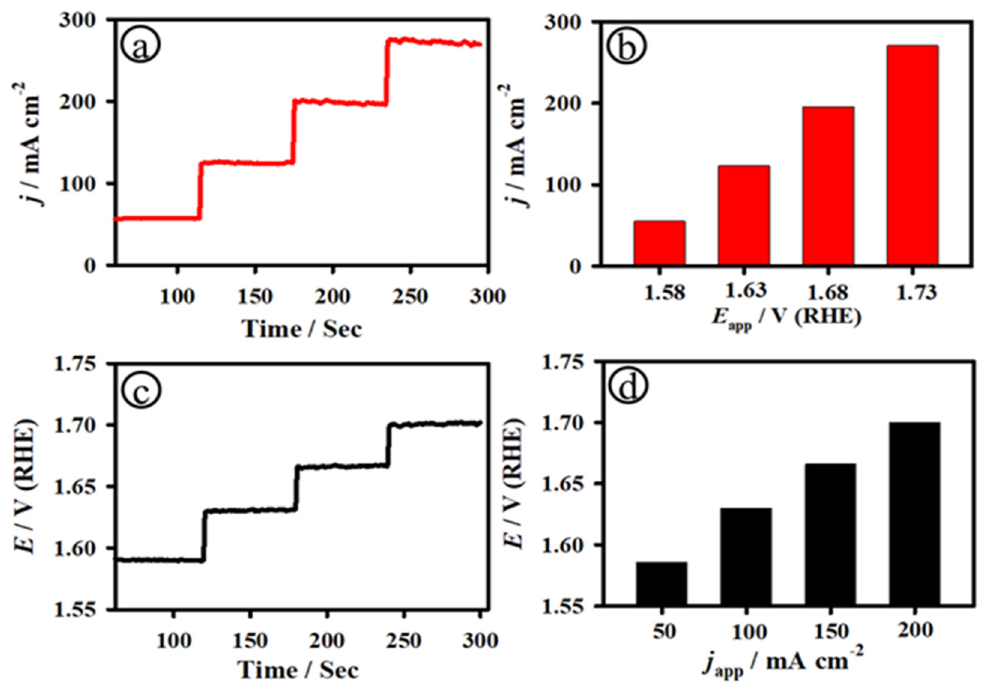
Figure 8. ( a ) Chronoamperometric response of the PS-3D-FeP@NiO|Ni electrode at different applied potentials of ~1.58, ~1.63, ~1.68, and ~1.73 V (vs. RHE); ( b ) The plot of the measured current density of the PS-3D-FeP@NiO|Ni electrode vs. different applied potentials; ( c ) Chronopotentiometric response of the PS-3D-FeP@NiO|Ni electrode at different applied current densities of ~50, ~100, ~150 and ~200 mA cm − 2 . ( d ) The plot of the measured electrode potential of the PS-3D-FeP@NiO|Ni electrode vs. different applied current densities. Table 1. Comparison of the OER performance of the developed PS-3D-FeP@NiO|Ni electrode with the recently reported